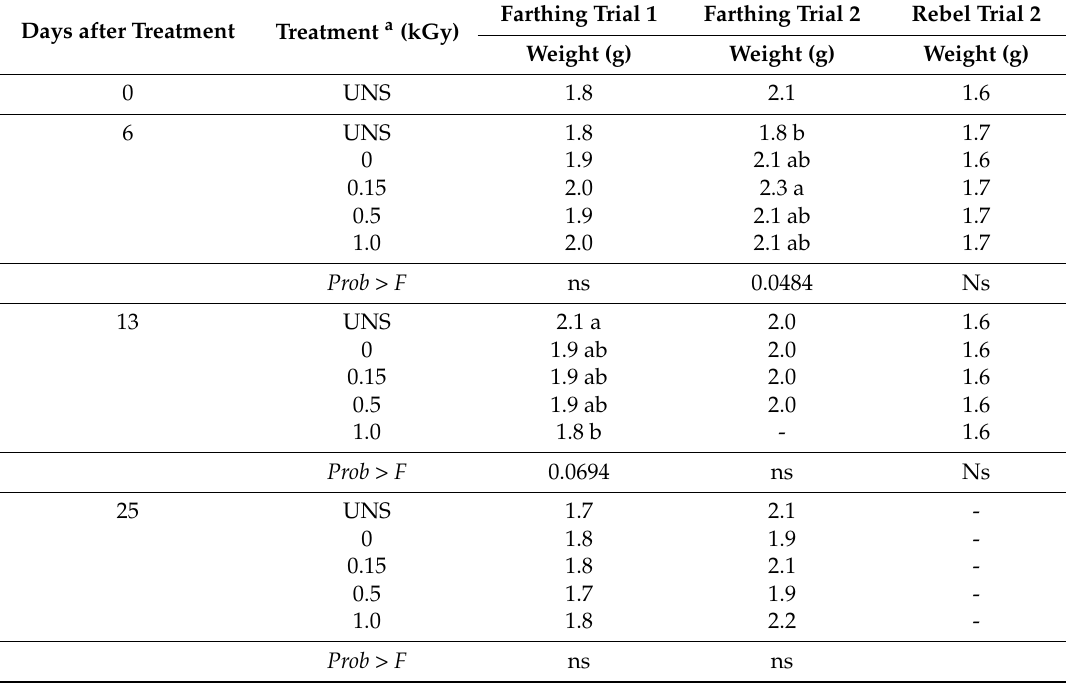
Table 2. Weight of ‘Farthing’ and ‘Rebel’ blueberry fruit subjected to Electronic Cold-Pasteurization TM followed by different cold storage